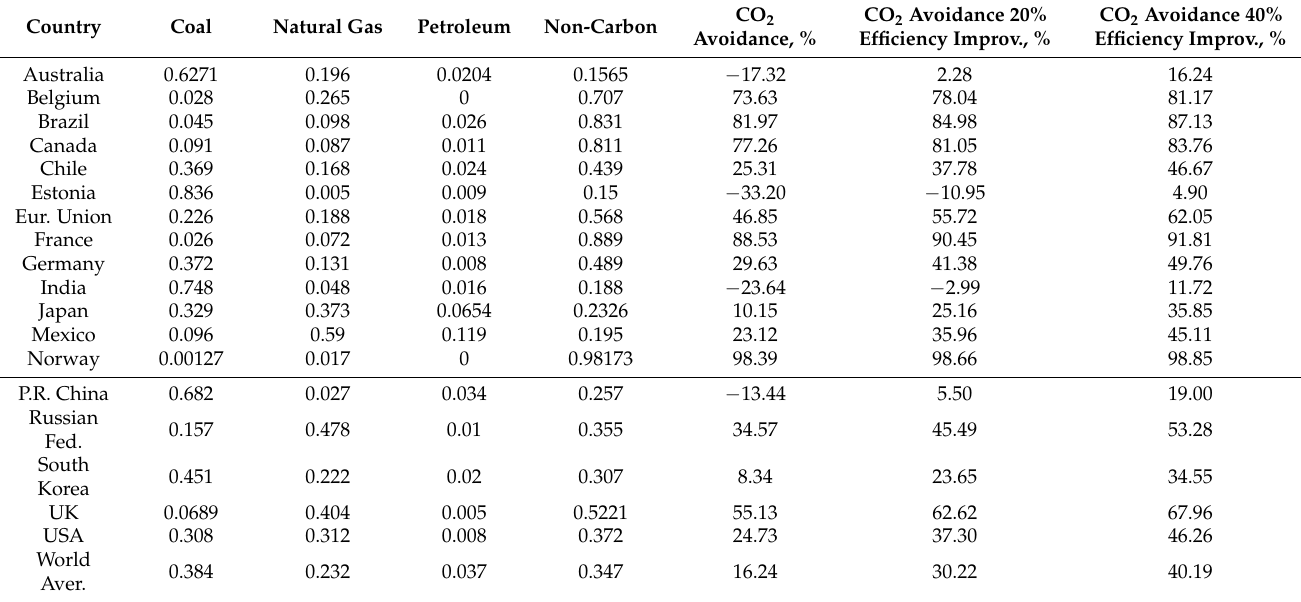
Table 3. CO 2 emissions avoidance related to the substitution of ICPVs with